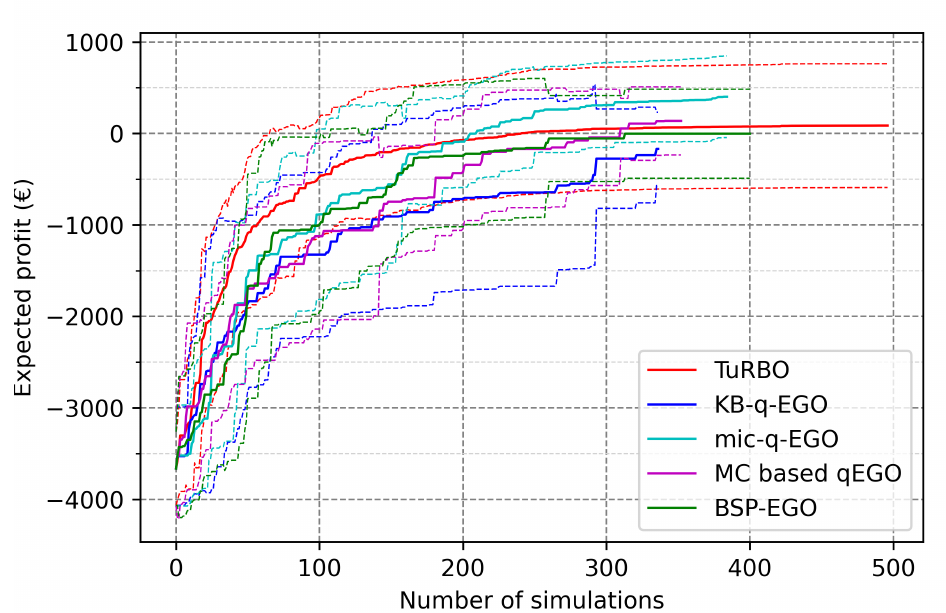
Figure 6. Evolution of the best-known objective value according to the number of executed cycles with n batch = 8. Solid lines indicate the average over 10 runs, and dashed lines of same colors indicate the standard